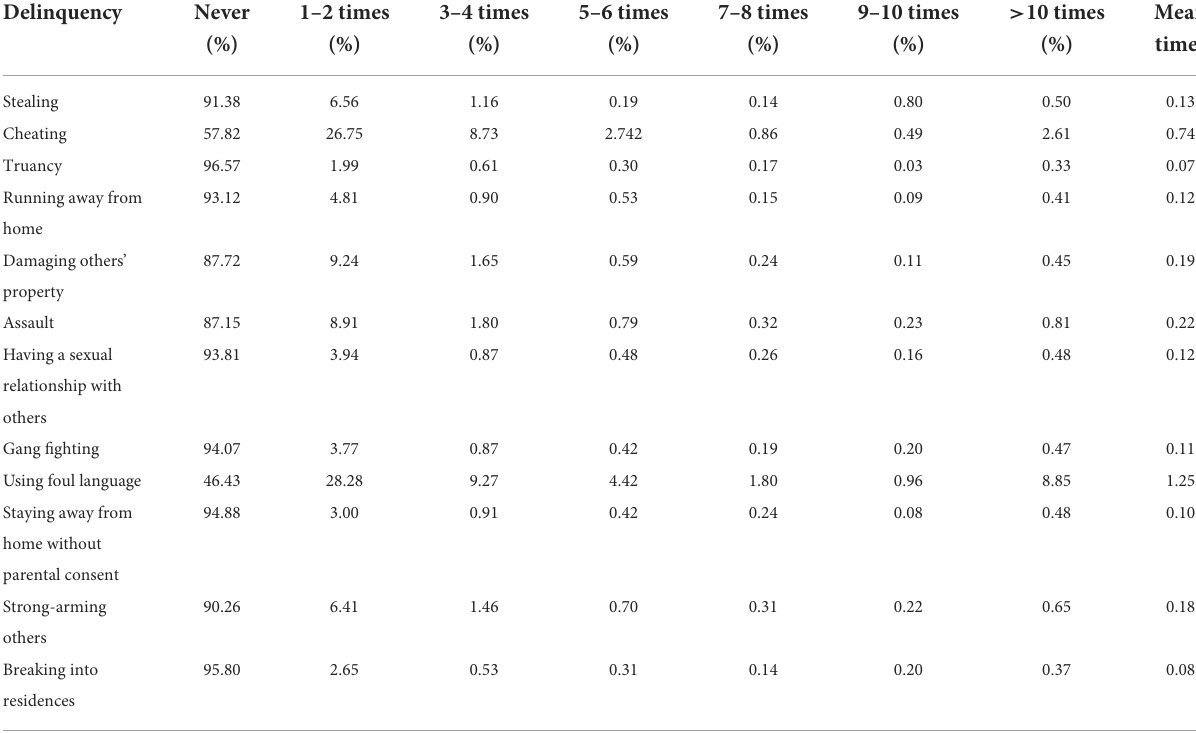
TABLE 1 Summary table of the reported frequency of delinquency behavior ( N = 8,811).